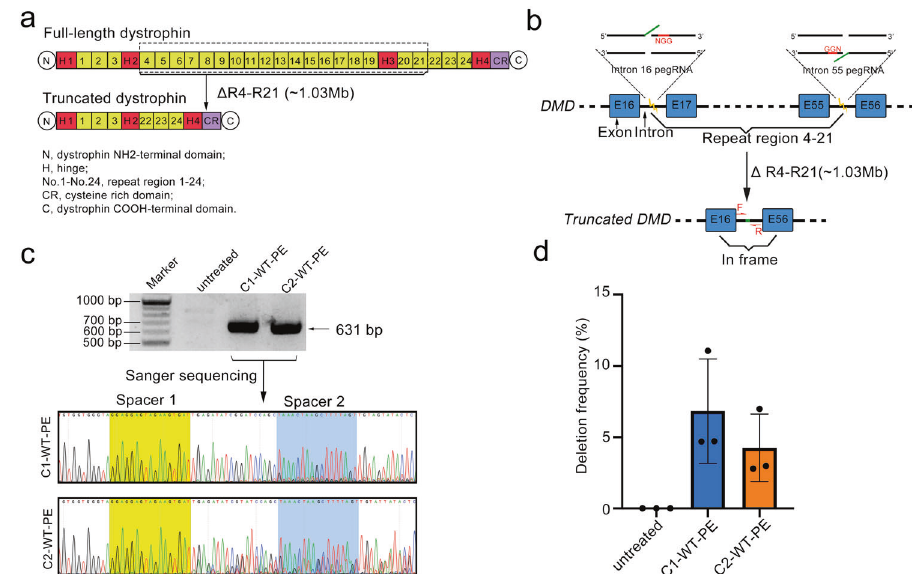
Fig. 4 Targeted deletion of Exons 17-55 of the human DMD gene. a Diagram showing the organization of the full-length or truncated dystrophin proteins. Note that this truncated version of dystrophin has been demonstrated to be functional (ref. 9 ). Key domains of dystrophin protein were shown below the diagram. Dotted box highlighted the domains to be deleted. b Diagram showing the design of pegRNAs for the targeted deletion (1.03 Mbs). ssDNAs extended by WT-PE were shown in green. c The presence of the targeted deletion was detected by PCR analysis with primers fl anking each side of the deletion shown in ( b ). Upper panel showed the agarose gel image of the resulting amplicons and lower panel showed their Sanger sequencing chromatograms with residue spacer sequences marked with yellow. Primers for PCR analysis were listed in Supplementary Table 4. d Quantifying the frequencies of targeted deletions by absolute quantitative PCR. The standard curves of wildtype- or edited-chromosome speci fi c fragment were shown in supplementary Fig. 11. Plots showed mean ± s.d. of three independent biological